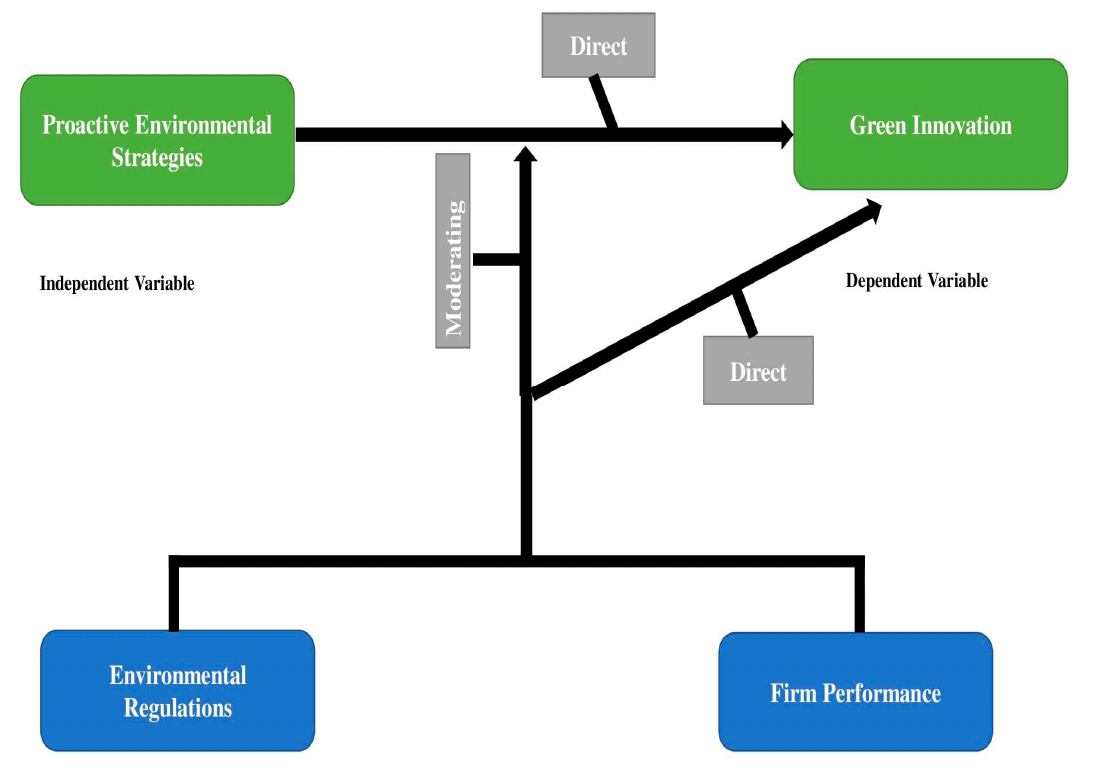
Figure 1. Conceptual diagram.